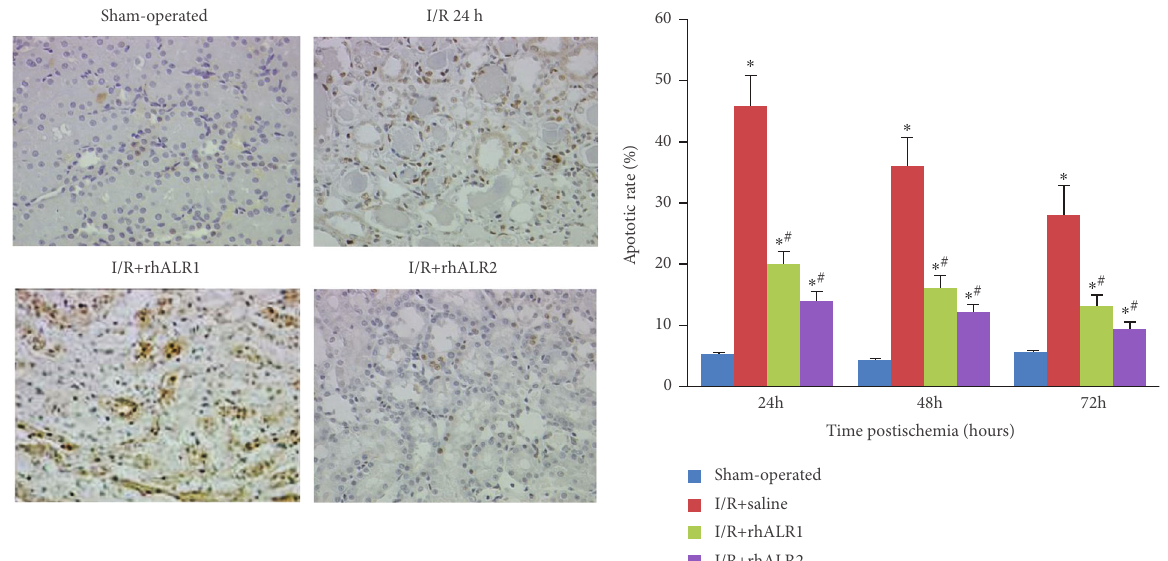
Figure 2: rhALR attenuates renal damage after I/R injury. The 24-hour representative kidney sections were shown above. TUNEL staining showed that TUNEL-positive apoptotic cells in the renal tubules of the sham operation group were few at fi rst, but the number of TUNEL- positive apoptotic cells increased 24 h after operation and reached a peak at 72 h. The renal function level of the I/R group was the same. The number of TUNEL-positive cells in the rhALR1 and rhALR2 groups was lower than that in the I/R group at these three time points (magni fi cation × 400). All data were presented as the mean ± standard deviation . ∗ P < 0 : 05 vs sham, # P < 0 : 05 vs.